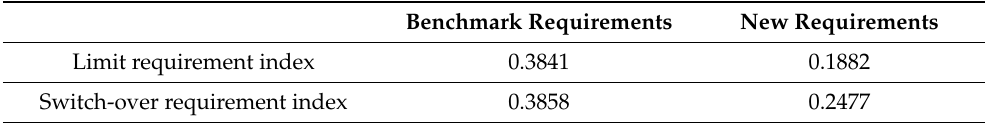
Table 2. Comparison of requirement indices between the benchmark and new